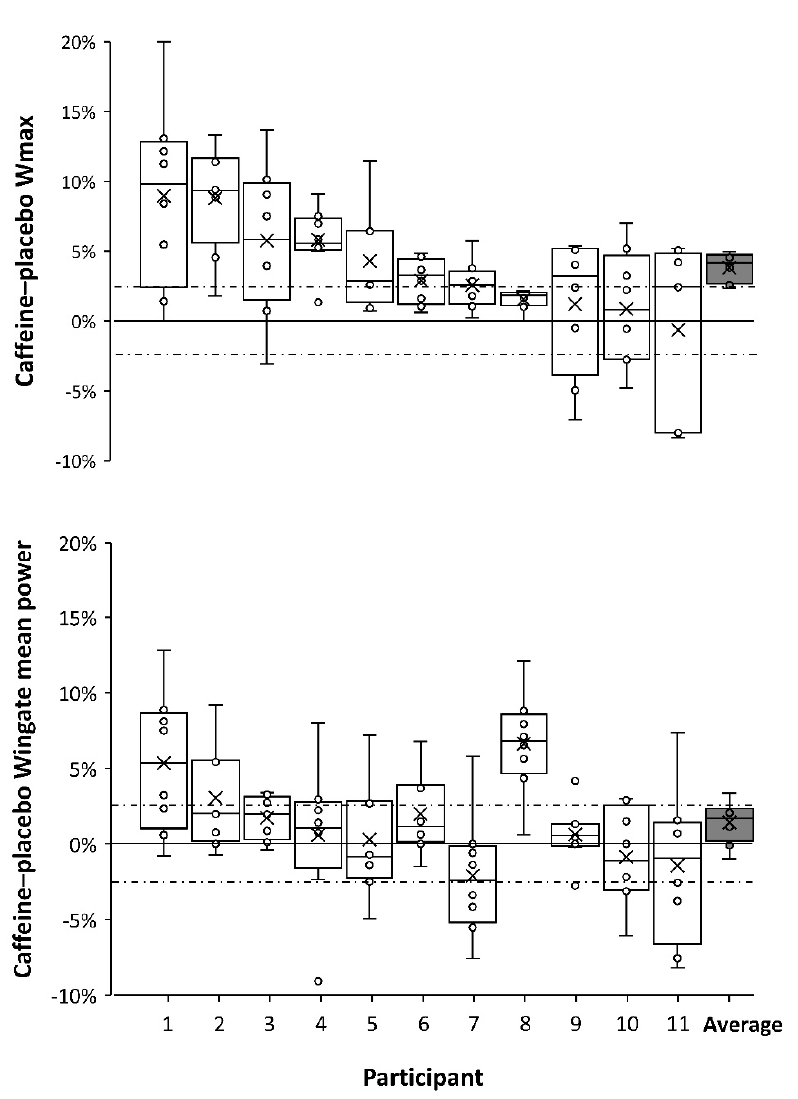
Figure 1. Box-and-whisker plots for the ergogenic effects of 3 mg/kg of caffeine on cycling power during a graded exercise test (upper panel) and during a 15-second Wingate test (lower panel). Caffeine was compared to a placebo on eight different occasions and each plot represents the results of these eight caffeine–placebo comparisons for each participant. “Average” represents the mean values for all 11 participants. The cross depicts the mean value for each individual while the lower, middle, and upper lines of the box represent the 25%, 50%, and 75% percentile for each individual. Whiskers represent the lowest and highest values (range). The black dashed line represents the natural variation of the graded exercise test ( ± 2.4%) and the 15-second Wingate test ( ± 2.7%) measured during the placebo treatment.